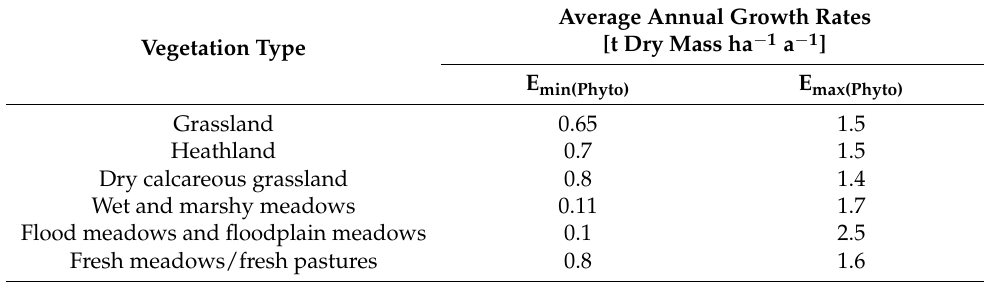
Table 5. Range of yield potentials (dry matter DM) of the different vegetation types of the forest-free near-natural/semi-natural ecosystems [13].